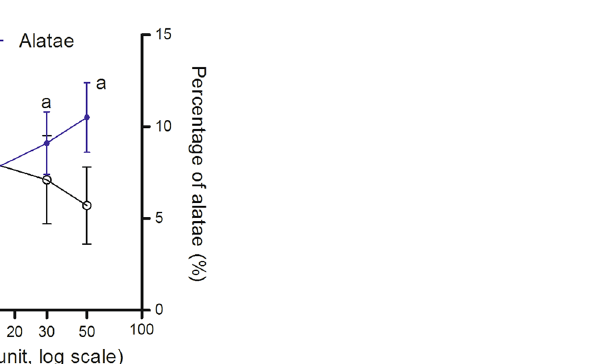
Figure 2. Modulation of population density on alate morphs production of Rhopalosiphum maidis : ( a ) Crowding treatment at 1 st instar; ( b ) Crowding treatment at 2 nd instar. The curved lines in ( a ) and ( b ) were generated based on the regression model using the data shown in the scatterplot in each graph. Different letters indicate significant differences ( P < 0.05) by using Tukey’s multiple range tests.